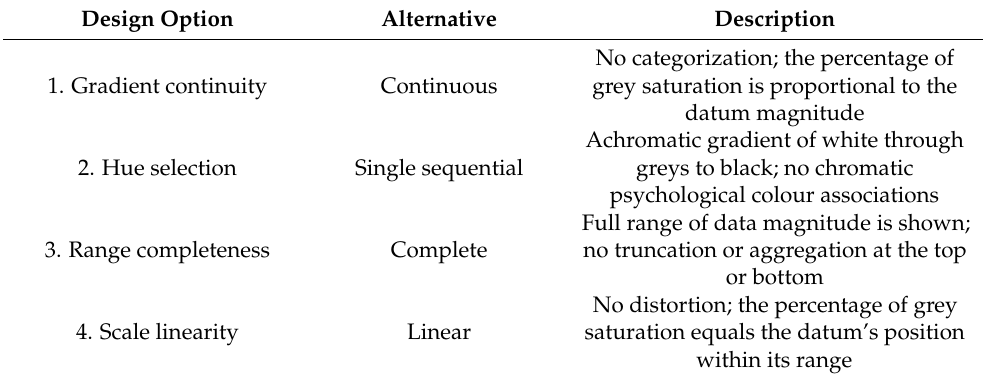
Table 3. The baseline case alternatives for the design options. This is a starting point that presents complete and accurate information, while ignoring the goals of a quick and easy understanding of the